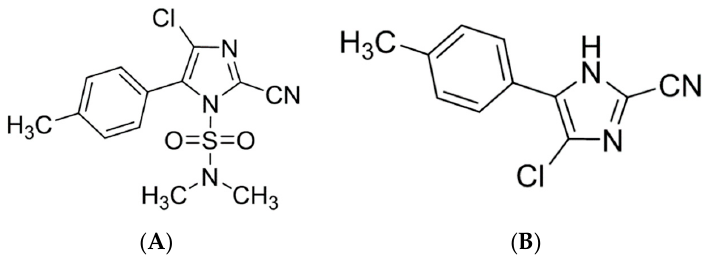
Figure 1. The chemical structures of cyazofamid and CCIM. ( A ) Cyazofamid; ( B ) CCIM.